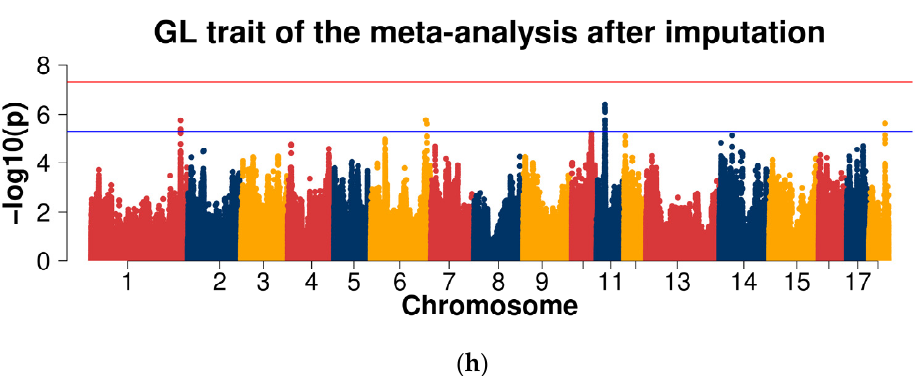
Figure 4. Manhattan plots of association results of different populations for the gestation length (GL) trait using chip data ( a – d ) and imputed WGS data ( e – h ). ( a , e ) Canadian line; ( b , f ) French line; ( c , g ) combined lines of Large White pigs; ( d , h ) cross-population meta-analyses.